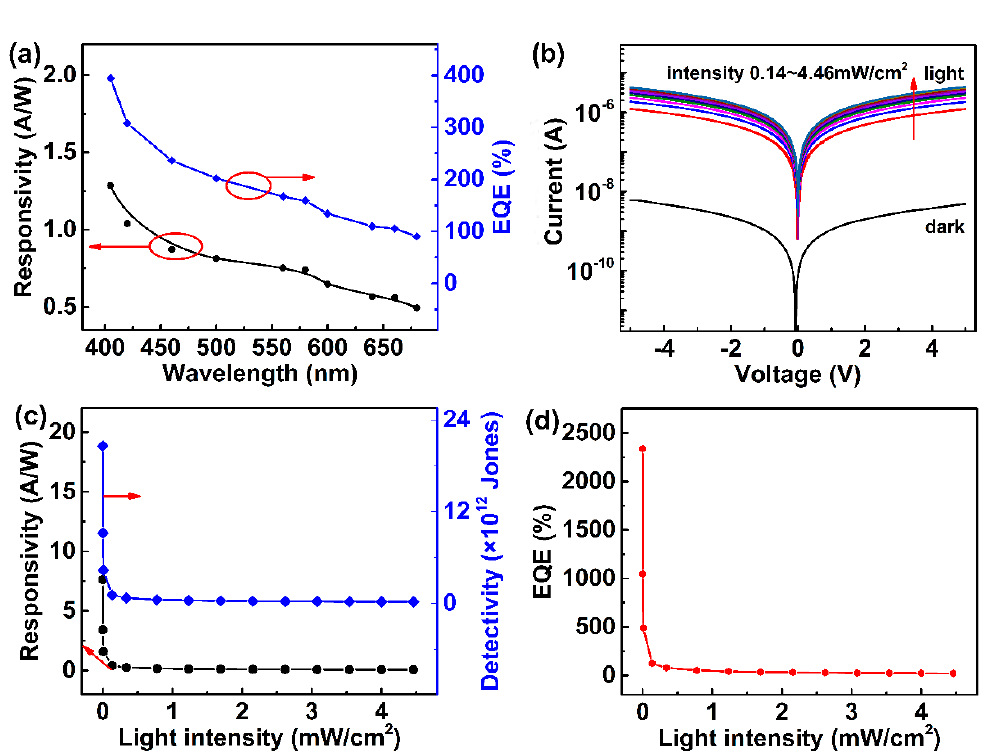
Figure 5. ( a ) Spectral photo response performance of the S2 device at a wavelength ranging from 400 to 700 nm under a fixed incident light intensity of 13 µW/cm 2 . ( b ) The log-scale dark and light IV curves of the S2 photodetector under 405 nm light illumination. ( c ) Responsivity and specific detectivity, ( d ) EQE of the S2 photodetector under 405 nm light with different intensities at a bias of 5 V.